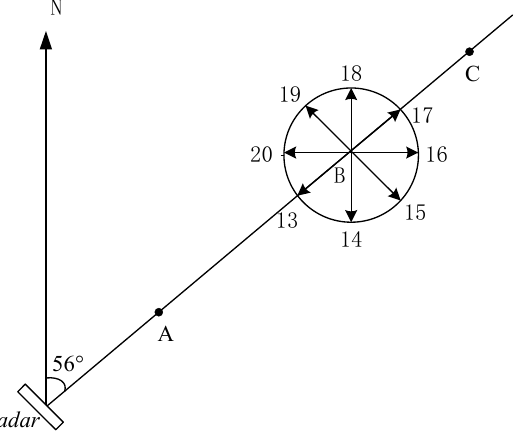
Figure 2. Schematic plot of the RCS measurement experimentation.